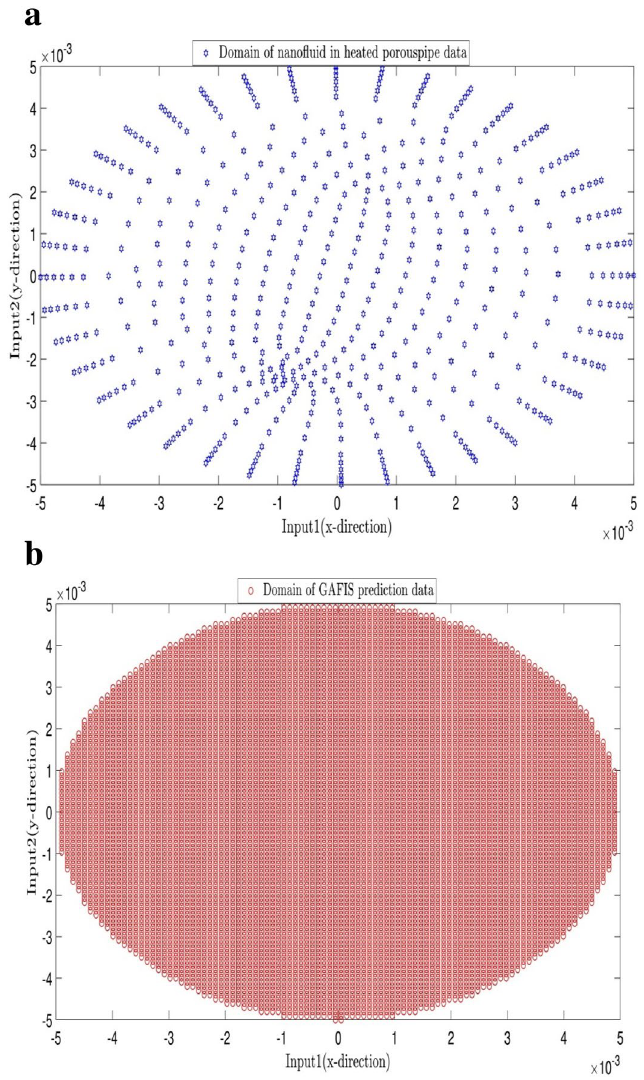
Figure 11. ( a ) CFD nodes which is considered in learning process (537 nodes). ( b ) Remeshed domain from 537 to 7671 nodes for